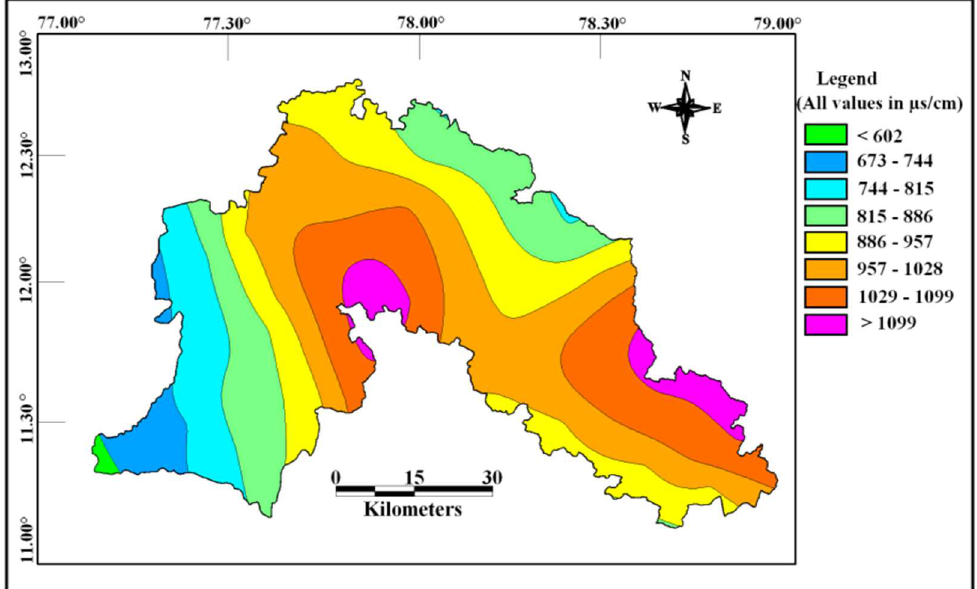
Figure 3. Spatial distribution of EC in the study area.